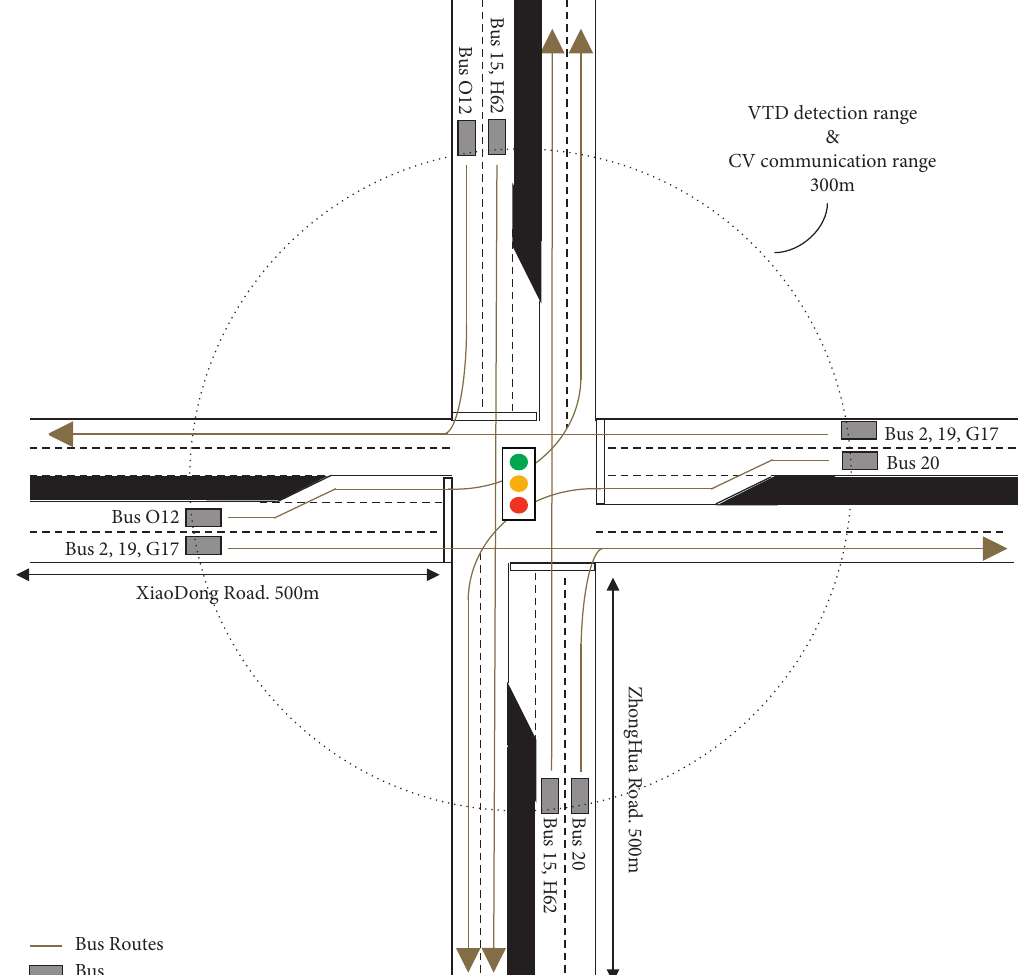
Figure 10: Layout and bus routes for the intersection of XiaoDong and ZhongHua Road.